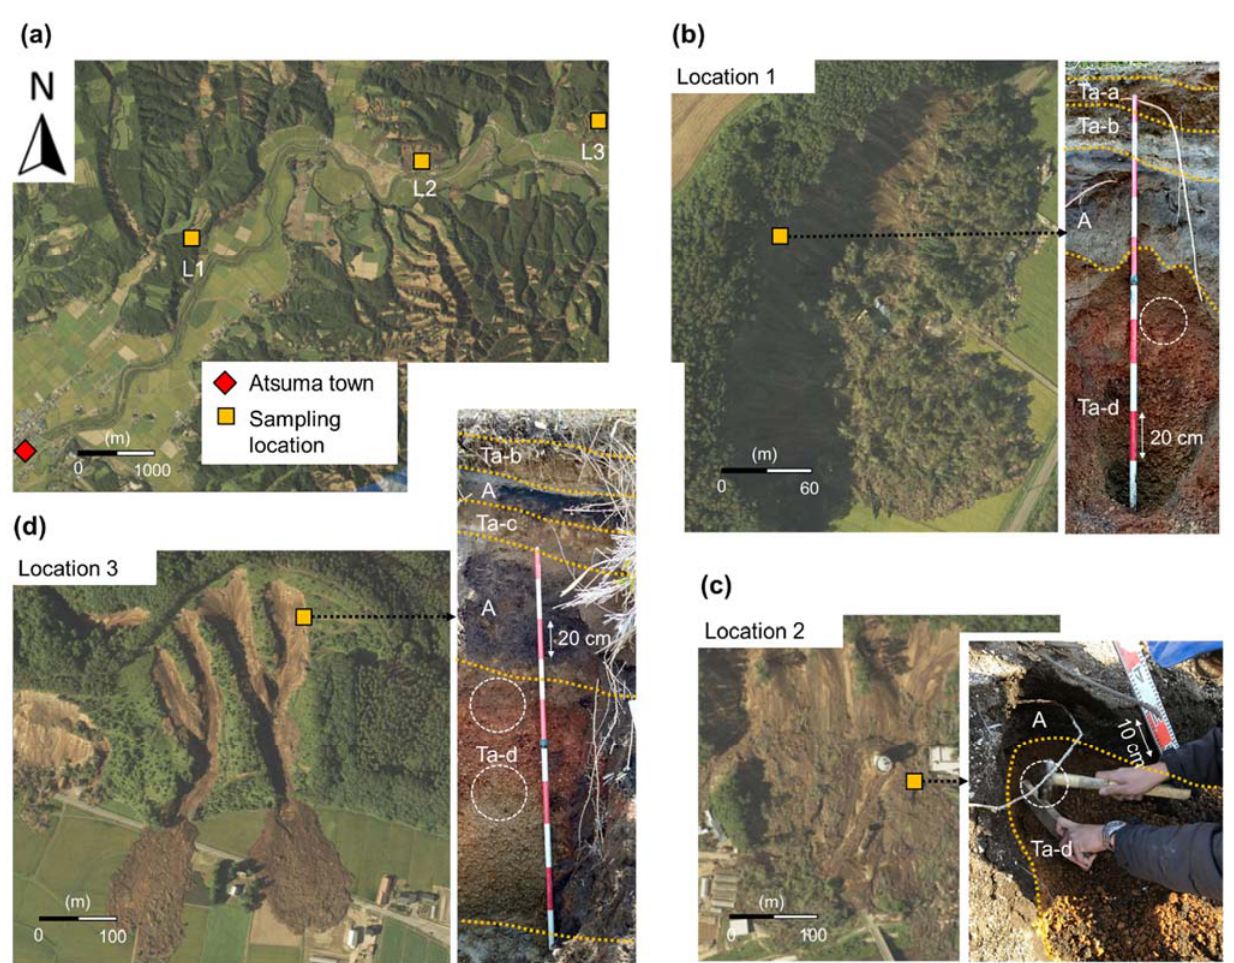
Figure 2. ( a ) General location of soil sampling. Landslide and soil conditions at ( b ) sampling location 1, ( c ) sampling location 2, and ( d ) sampling location 3. Ta is the Tarumae deposit that consists of Ta-a (1739 A.D.), Ta-b (1667 A.D.), Ta-c (2.5 ka), and Ta-d (8.7–9.2 ka). “A” represents volcanic ash soil. The white-dashed circle indicates the location where soil samples were collected.